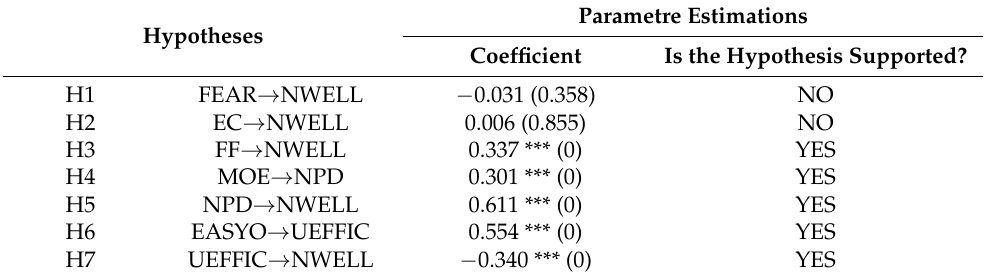
Table 4. The results of the estimations.